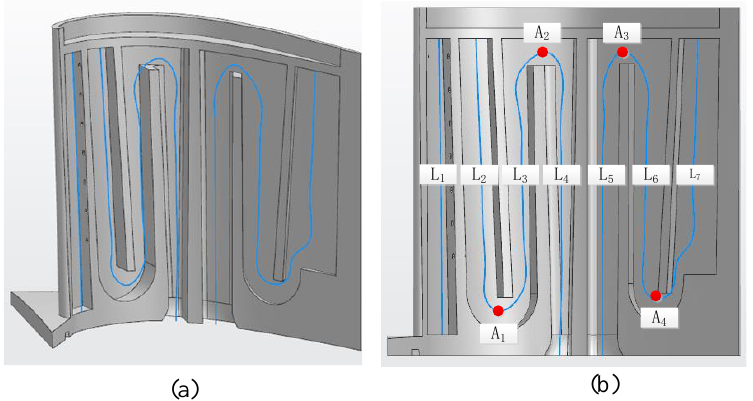
Figure 11. Skeleton line adaptive division method: ( a ) Extraction of skeleton lines imitating fluid flow. ( b ) Result of skeleton lines adaptive